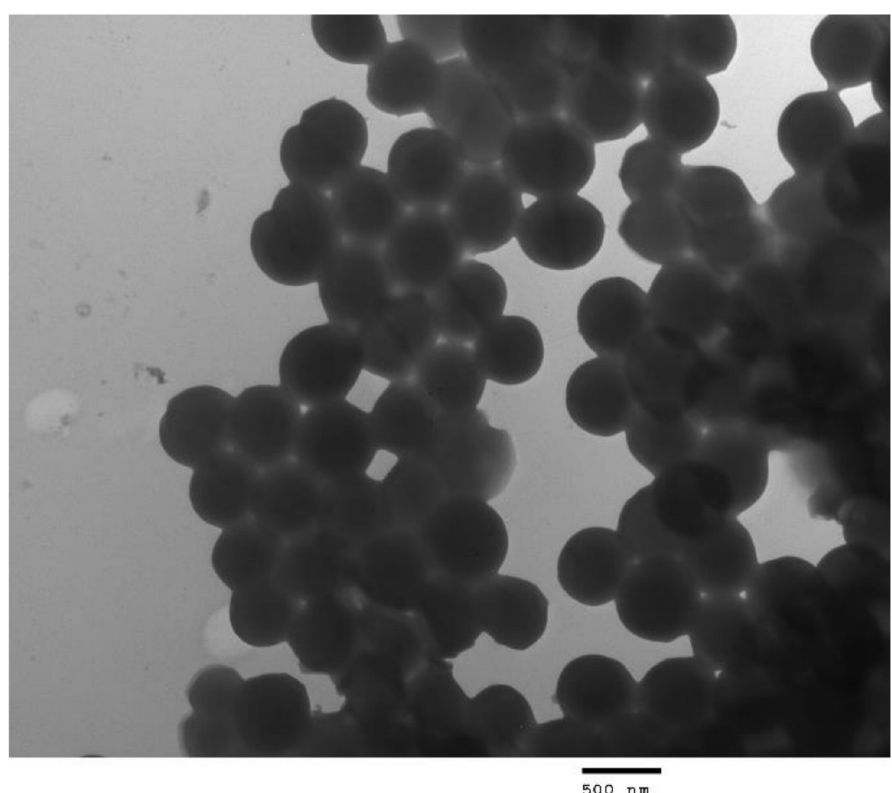
Fig 4. Transmission electron microscope image of HXBM408.